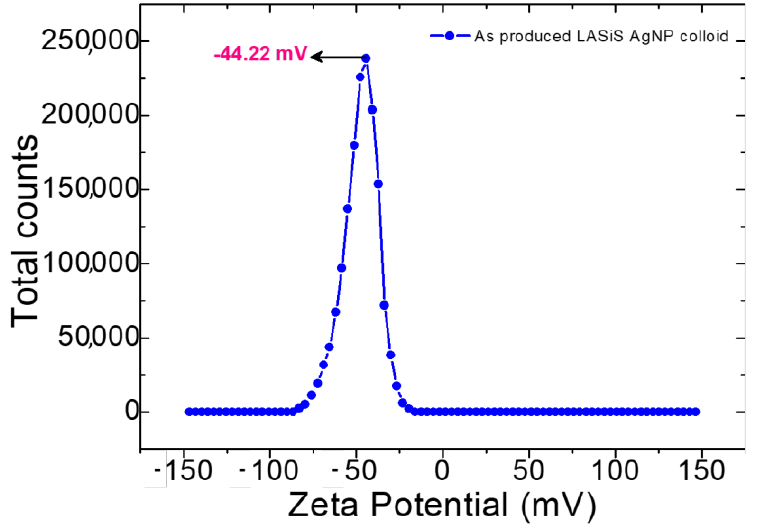
Figure 3. Zeta potential of as produced LASiS AgNPs.